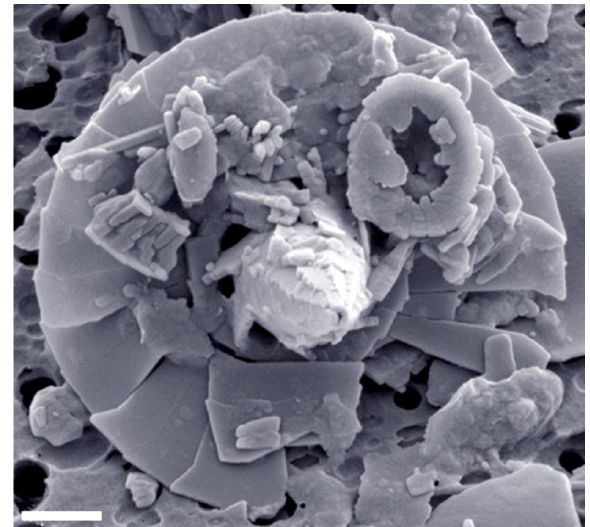
Figure 3. Fossil exothecal coccolith of Syracosphaera kareniae , ODP 1000A-16H-1, 55cm. Scale bar: